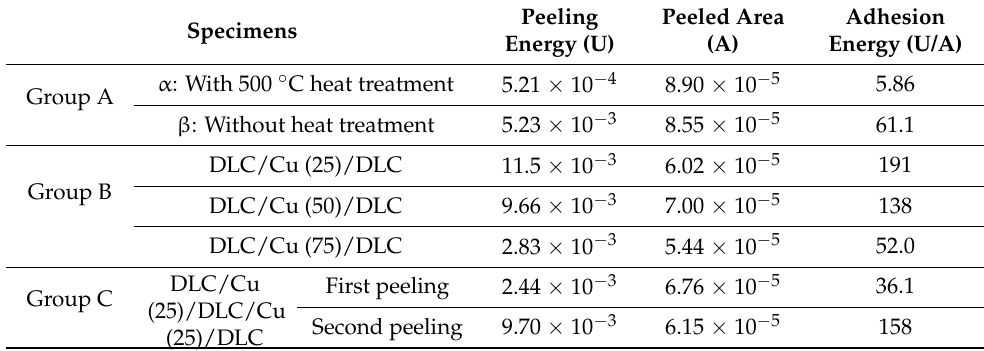
Figure 8. Appearance of samples in ( a ) group A, ( b ) group B, and ( c ) group C. Table 4. Peeling properties of the samples in each